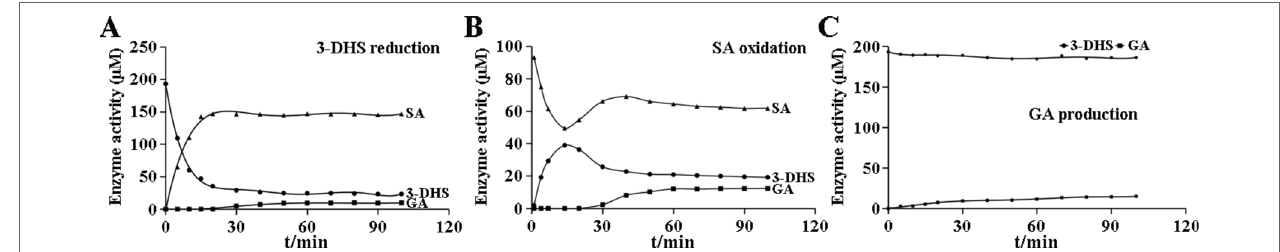
FIGURE 4 | Enzymatic reaction time of the recombinant protein Cs DQD/SDHa in vitro . (A) The time course of the 3-DHS reduction reaction catalyzed by the Cs DQD/SDHa enzyme. (B) The time course of the SA oxidation catalyzed by the Cs DQD/SDHa enzyme. (C) GA production in a reaction catalyzed by the Cs DQD/ SDHa enzyme. 3-DHS, 3-dehydroshikimate; SA, shikimate; GA, gallic acid.